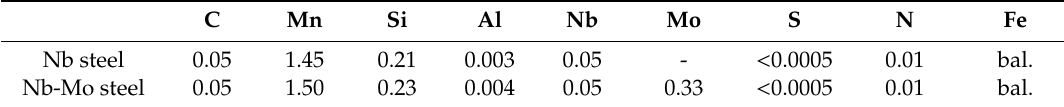
Table 1. Compositions of the studied steels, wt